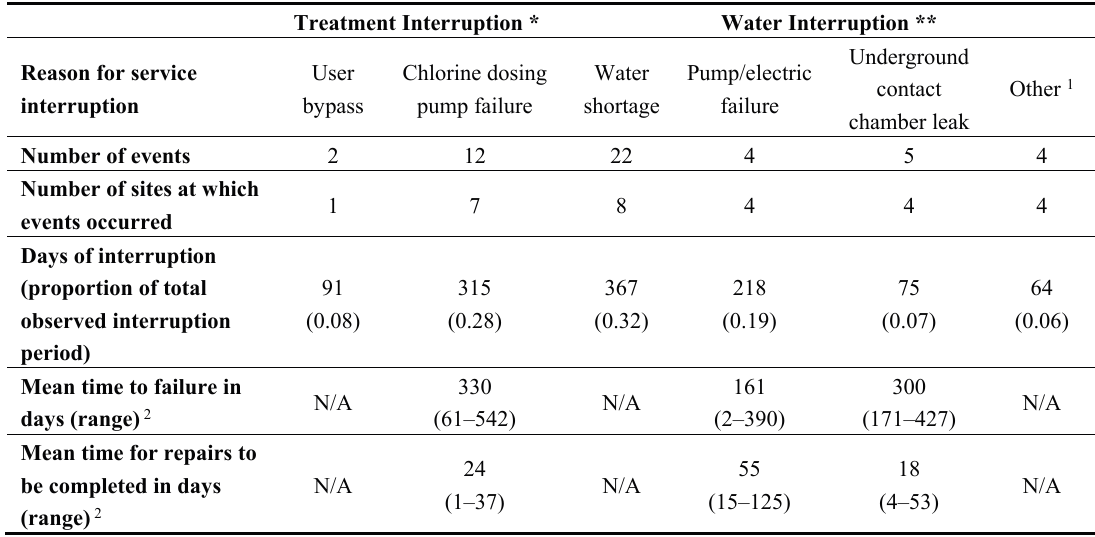
Table 1. Causes and duration of water treatment system service interruptions at ten health centers in rural Rwanda, March 2012–December